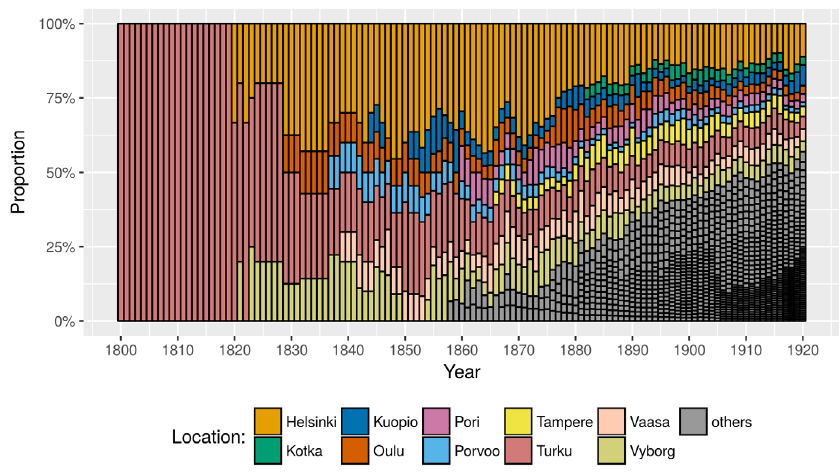
Fig. 11 The proportions of all newspapers published in selected towns,